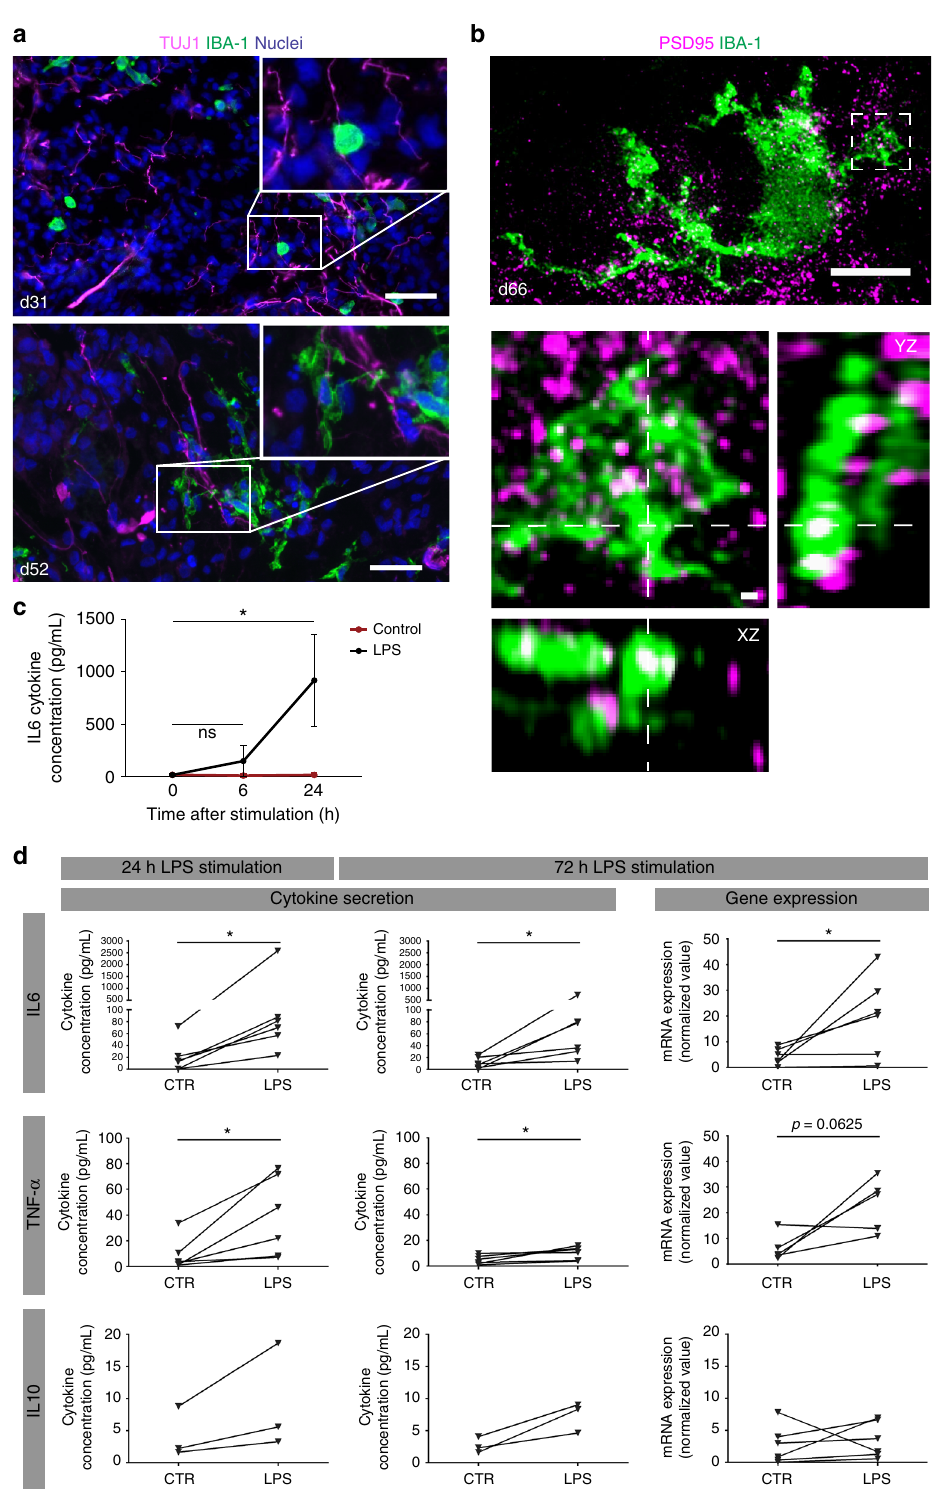
(ELISA) indicating an acute and long-term effect (Fig. 5d). Increased mRNA levels of IL6 and TNF , but not of IL10 , were detected after 72 h of LPS stimulation (IL6: W = 21, p = 0.03; TNF- α : W = 19, p = 0.06) (Fig. 5d). The cytokine response to LPS detected in the medium was low as compared to assays performed with isolated oMG. However, this is expected considering that only